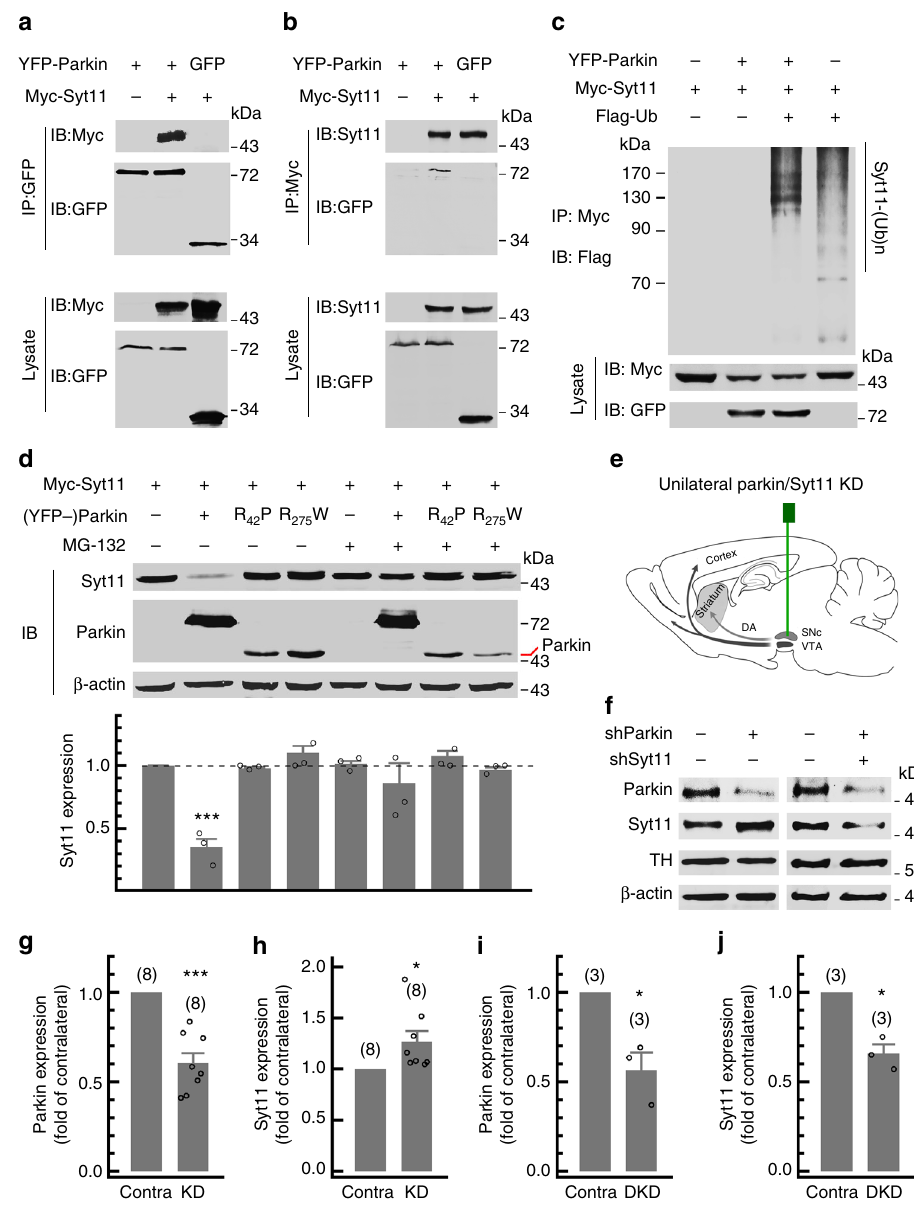
Fig. 1 Effect of Parkin dysfunction on Syt11 accumulation. a , b Co-immunoprecipitation of Syt11 with parkin. YFP-parkin (or GFP) and Myc-Syt11 was co- expressed in HEK293 cells, and the lysates were immunoprecipitated (IP) with anti-GFP or anti-Myc antibodies, followed by immunoblotting (IB) with antibodies as indicated. Whole-cell lysates were also immunoblotted with the indicated antibodies as controls. c Parkin catalyzes the ubiquitination of Syt11. Ubiquitination of Syt11 in HEK293 cells expressing combinations of Myc-Syt11, YFP-parkin, and Flag-ubiquitin (Flag-Ub) as indicated. Cell lysates were immunoprecipitated with anti-Myc, followed by immunoblotting with anti-Flag antibody. d Parkin mediates proteasome-dependent degradation of Syt11. Immunoblotting for Syt11 in HEK293 cells expressing YFP-parkin or parkin mutants (R42P disrupting the ubiquitin-like domain, or R275W disrupting the RING1 domain of parkin), with or without 12 h treatment with MG132 (10 μ M). Data were collected from three independent experiments ( P = 0.041 for ANOVA, P < 0.001 for further LSD test between Myc-Syt11/YFP-parkin and Myc-Syt11). e Cartoon of virus injection for unilateral parkin knockdown (KD) and parkin/syt11 double-KD in the SNpc. f Representative western blots showing the expression of parkin, Syt11, and TH in the bilateral SNpc from parkin KD and parkin/syt11 double-KD mice 1 month after virus injection as in e . g – j Statistics of parkin and Syt11 expression in the SNpc from mice as indicated ( P = 0.000, 0.040, 0.047, and 0.022; number in parentheses represents number of mice/biological repeats). Data are shown as mean ± s.e.m. One-way ANOVA for d and paired Student ’ s t -test for g – j , * P < 0.05, *** P < SNpc with Syt11-OE at 3 months after injection, while no sig- counting of TH-positive neurons in the Syt11-OE and ni fi cant loss of TH-positive neurons was found when control contralateral sides of the SNpc 20,33 . Interestingly, Syt11-OE failed virus was used (Fig. 3g, h). We also found positive terminal to induce a clear loss of dopaminergic neurons in the SNpc at one deoxynucleotidyl transferase dUTP nick end labeling (TUNEL) month after injection (Supplementary Fig. 5), despite the robust staining in the Syt11-OE, but not in the contralateral SNpc motor impairment (Fig. 2) and DA release defects (Fig. 3a – f) at (Fig. 3g), suggesting that these DA neurons degenerate through this stage. However, we observed ~35% loss of DA neurons in the